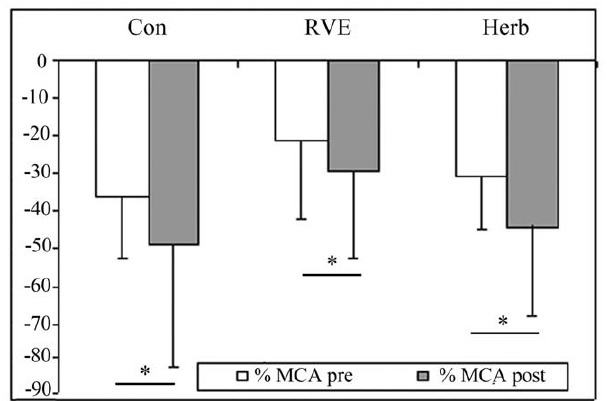
Figure 3. Percentage change in resistance in the femoral artery (FRI) from supine to tilt positions. FRI response decreased in the Con gr (p , 0.05), increased in the RVE gr (p , 0.05) and was maintained in the Herb gr. RVE and Herb contributed to maintain vasoconstrictive responses at the leg level but the effect of RVE was greater.